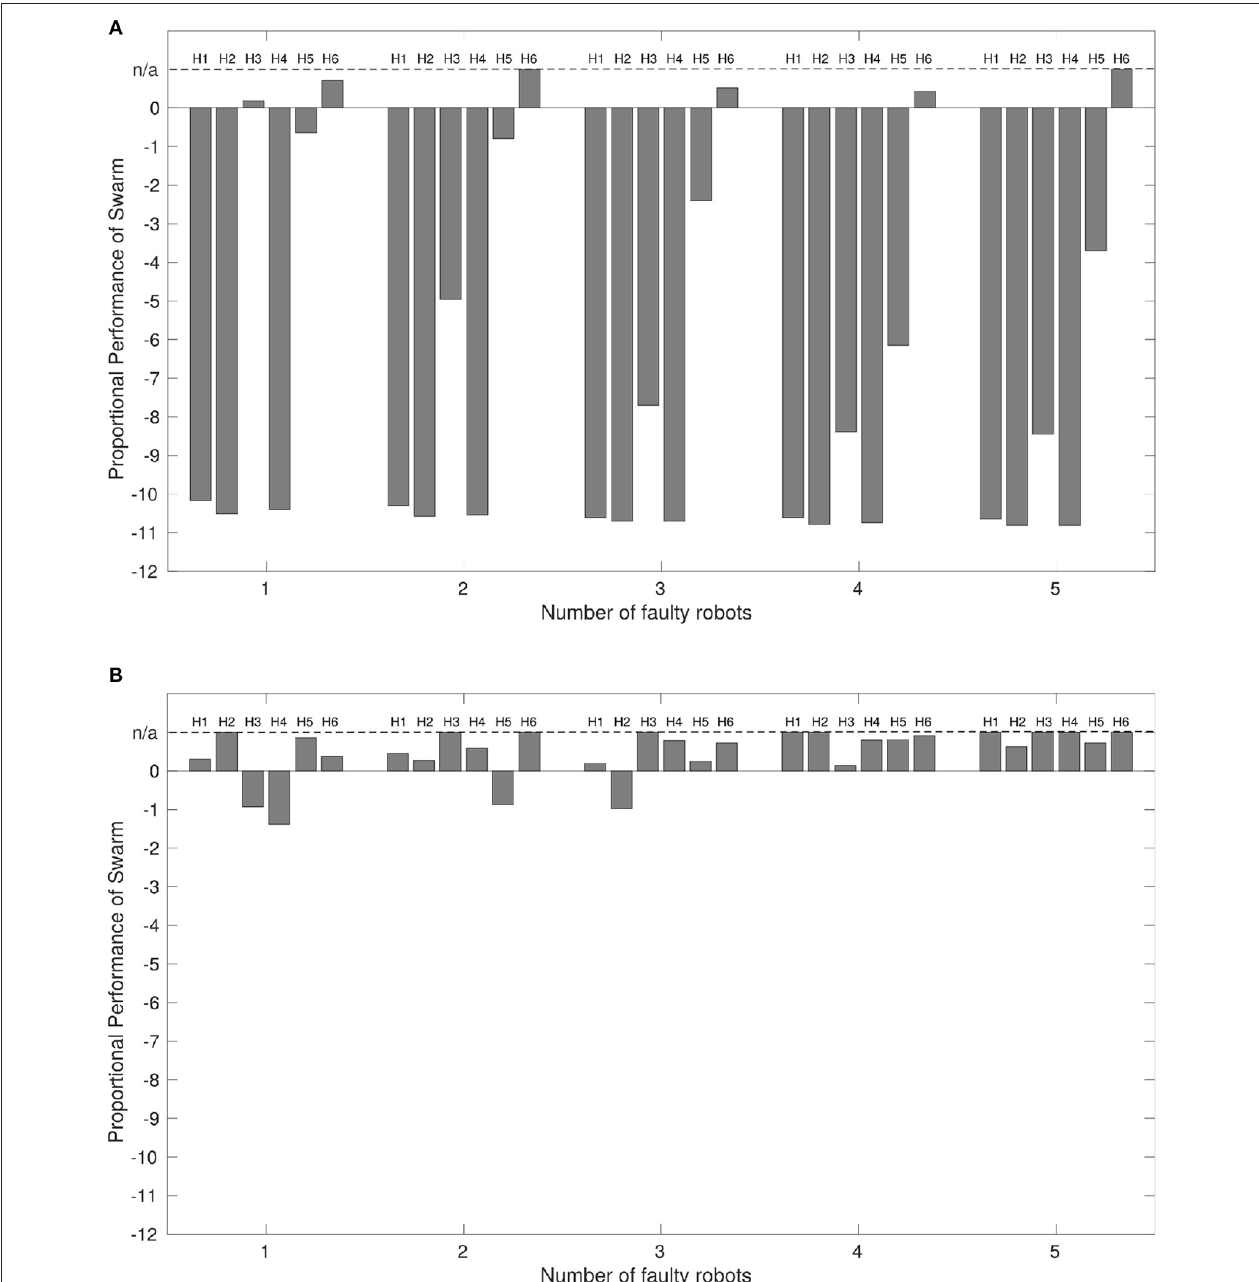
FIGURE 4 | (A) The performance of a robot swarm with no active fault tolerance exhibiting the collective photo-taxis when a varying proportion of robots are subjected to a variety of faults, and (B) The results of the same experiment with active fault tolerance. x = 0 indicates a performance equivalent with a normally functioning swarm. Results are taken from the median values of 100 experimental replicates. The dashed line at x = n/a indicates that proportional performance is not applicable because the entire swarm reached the beacon in < 24,388 time-steps, meaning that median average distances at t ≥ 24,388 control-steps could not be